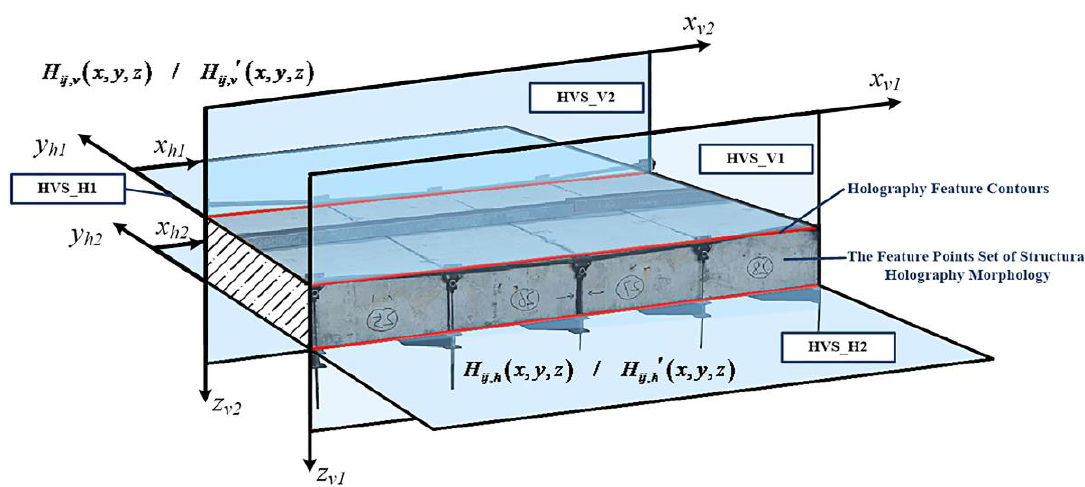
Figure 11. The feature points set of structural holography morphology and feature contours.